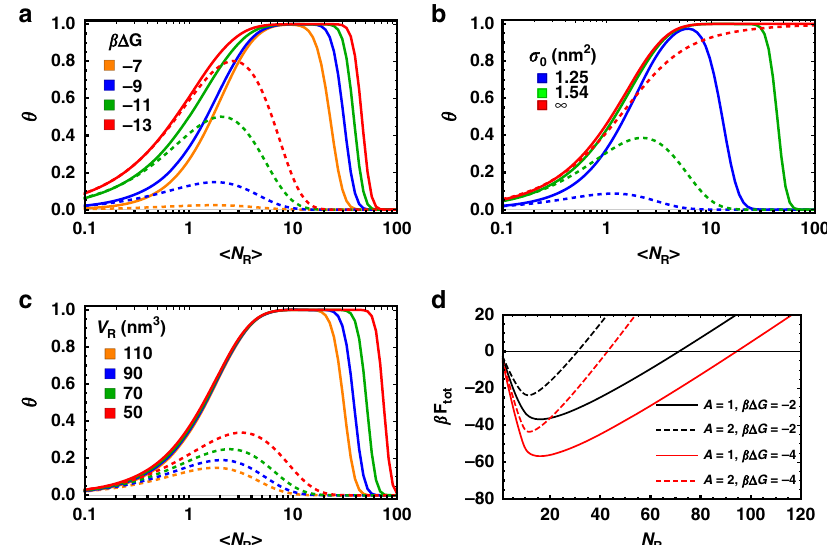
Fig. 2 Range-selective behaviour as a function of different parameters in the system. a – c we report the calculated value of the binding probability as a function of the number of receptors for different bond energies Δ G , area per polymer chain, σ 0 (i.e. the inverse grafting density of the polymer brush) and receptor volume, V R , respectively. Dashed and continuous lines refer to the indifferent Eq. (2) and radial binding scenarios, Eq. (3), which represent the upper and lower bound to the binding free-energy F att . Regardless of the binding scenarios the adsorption probability θ shows a non-monotonic behaviour and binding is only appreciable within a certain range of receptors' number. The various parameters, which are fi xed, are chosen to show in each case a range where the non-monotonic behaviour is observed. The nanoparticle size, number of interacting ligands and activity, are kept fi xed at R np = 50 nm, N L = 3, z = 10 − 9 M, the other values used are σ = 1.95 nm 2 , V R = 110 nm 3 , δ = 0.9; β Δ G = − 9, V R = 40 nm 3 , L = 9 nm and β Δ G = − 9, σ = 1.95 nm 2 , δ = 0 0 0.9 in panel a , b and c , respectively. Note that in panel b we keep fi xed the value of the length of the ligand rather than the insertion ratio δ . In all cases, we assume a zero contribution to the repulsive energy from the ligands, but its inclusion would only result in a rescaling of the activity z to lower values, from z ! z exp ð(cid:2) F repligands Þ , which does not affect trends observed here. d Total adsorption energy F A in tot for different values of the repulsion parameter Eq. (4) and Δ G , assuming a radial binding scenario and using N L = 10. Note that for illustration purposes the scales in panels a – c and in panel d are different (logarithmic vs linear). As A becomes larger the repulsion increases and as a result the minimum of the adsorption energy decreases (in absolute value) and shifts to lower N R . The opposite trend is observed by increasing the bond strength, which increases attraction. The non-monotonic behaviour of the adsorption energy observed here rationalises the trends observed in a – c